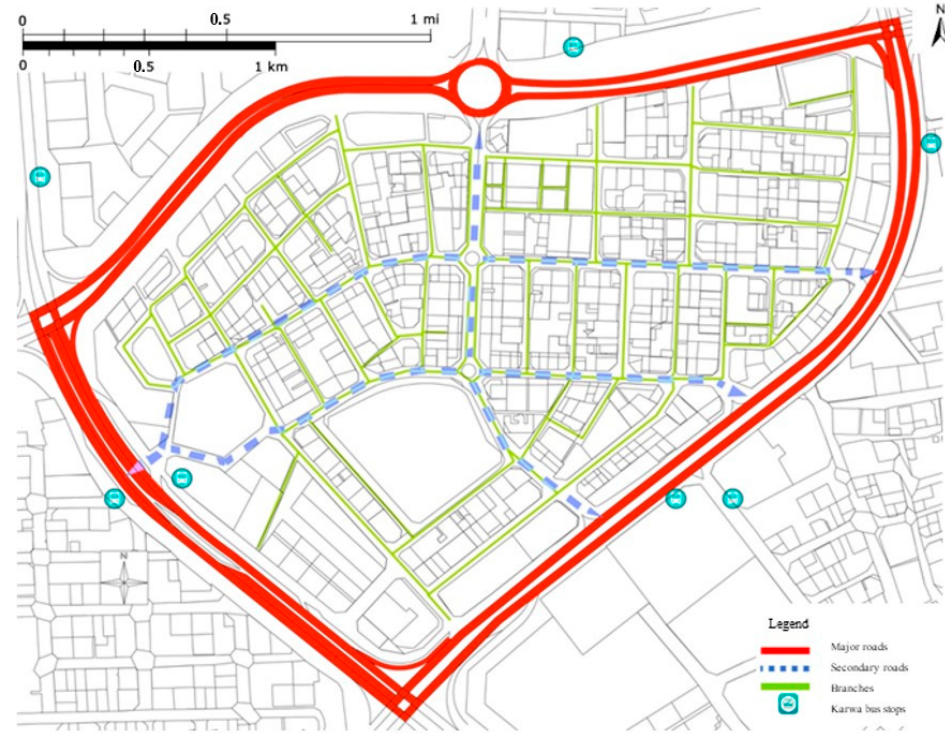
Figure 7. Connectivity lines (Source: the Authors).